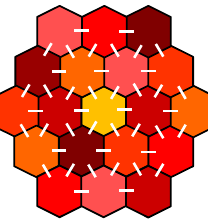
FIG. 4. Secondary electron images for the six cross-sectional areas examined by EBSD. Grain boundaries and the neck are marked in accordance with Fig. 2. The numbering is also the same as Fig.